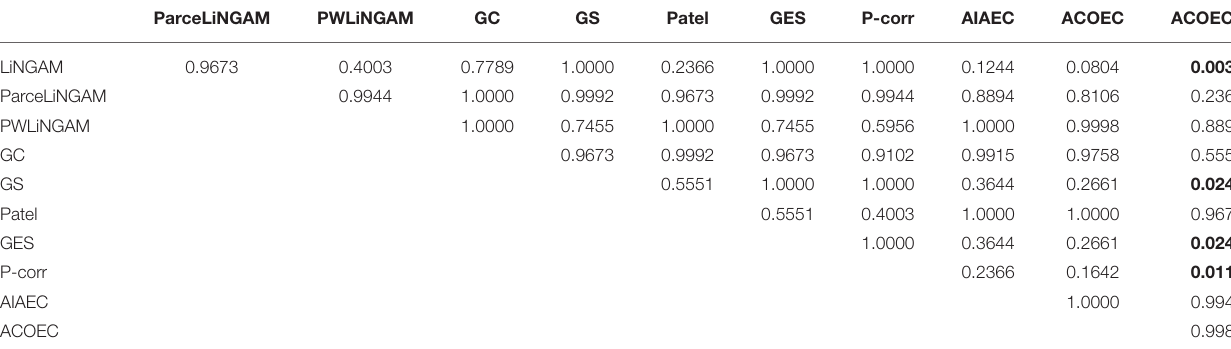
TABLE 6 | The post-hoc test results of p -values on REC value.